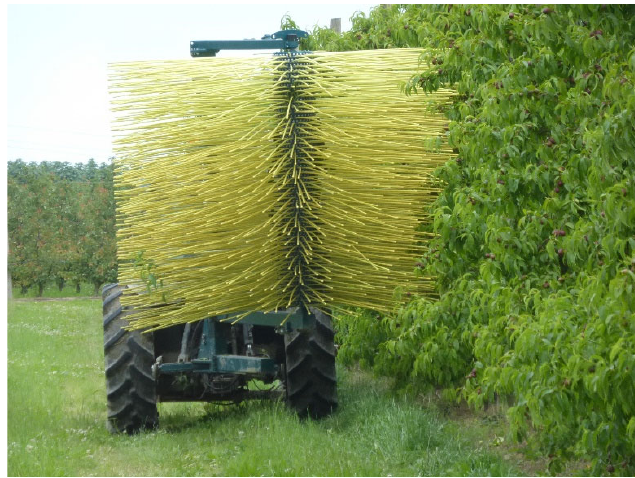
Figure 1. Rear view of working elements of the thinning machine.